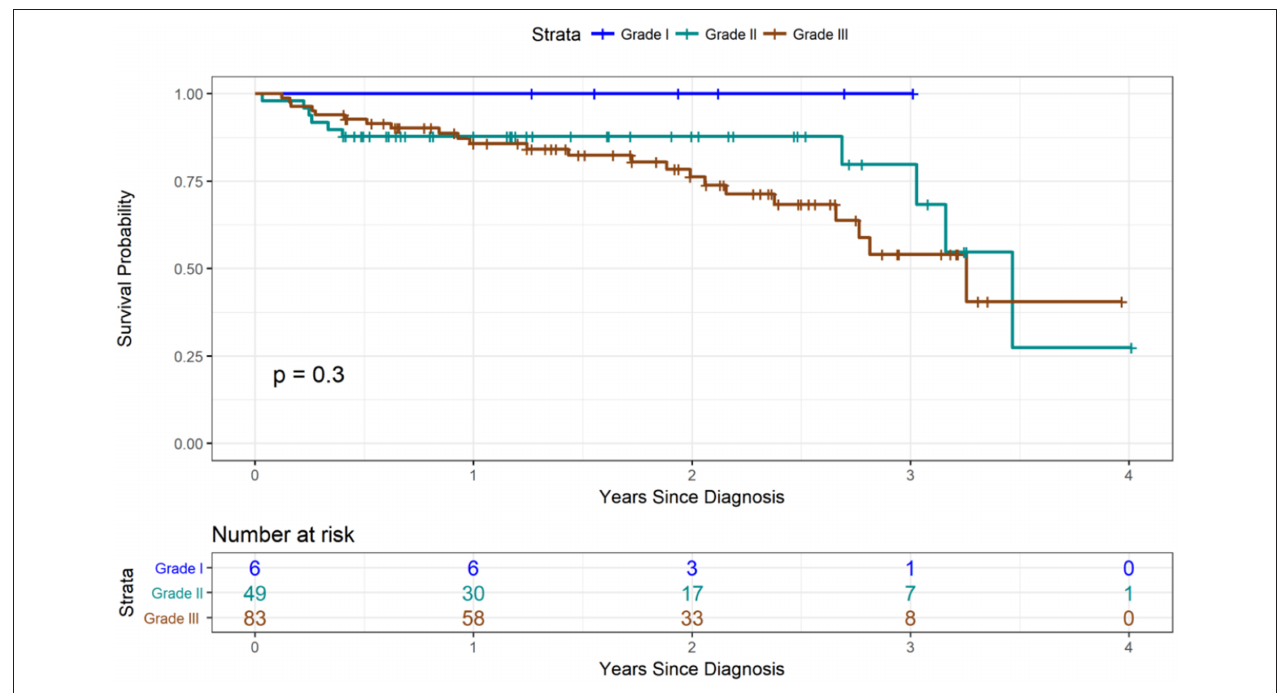
FIGURE 4 | Survival stratified by grade type. Three-year survival was approximately